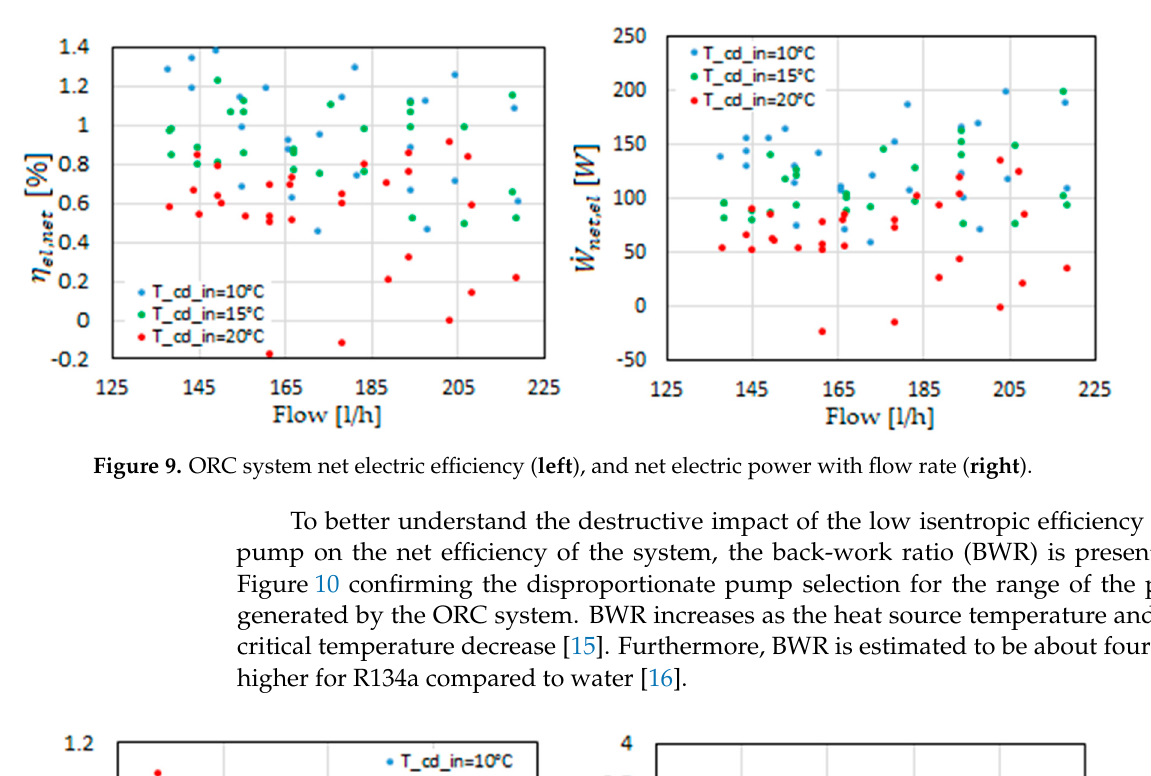
Figure 9. ORC system net electric efficiency ( left ), and net electric power with flow rate ( right ).